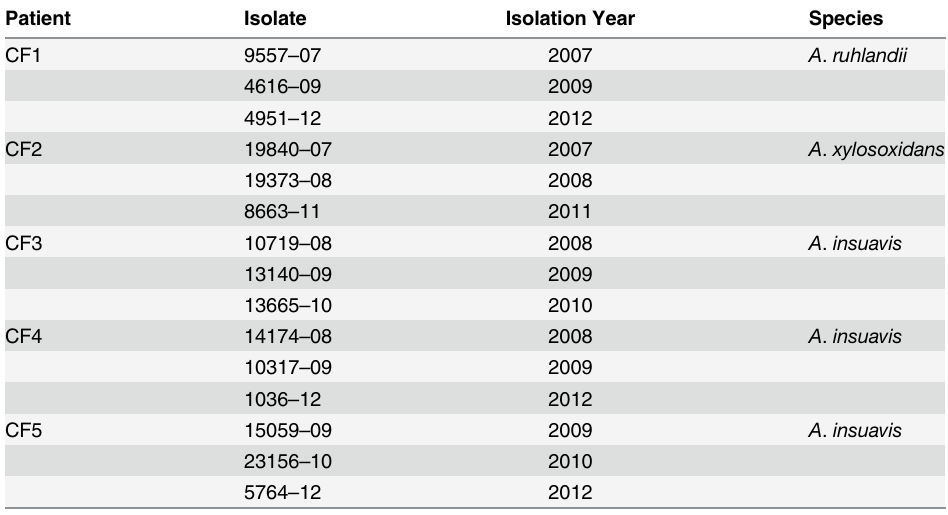
Table 1. Overview of patients and isolates.